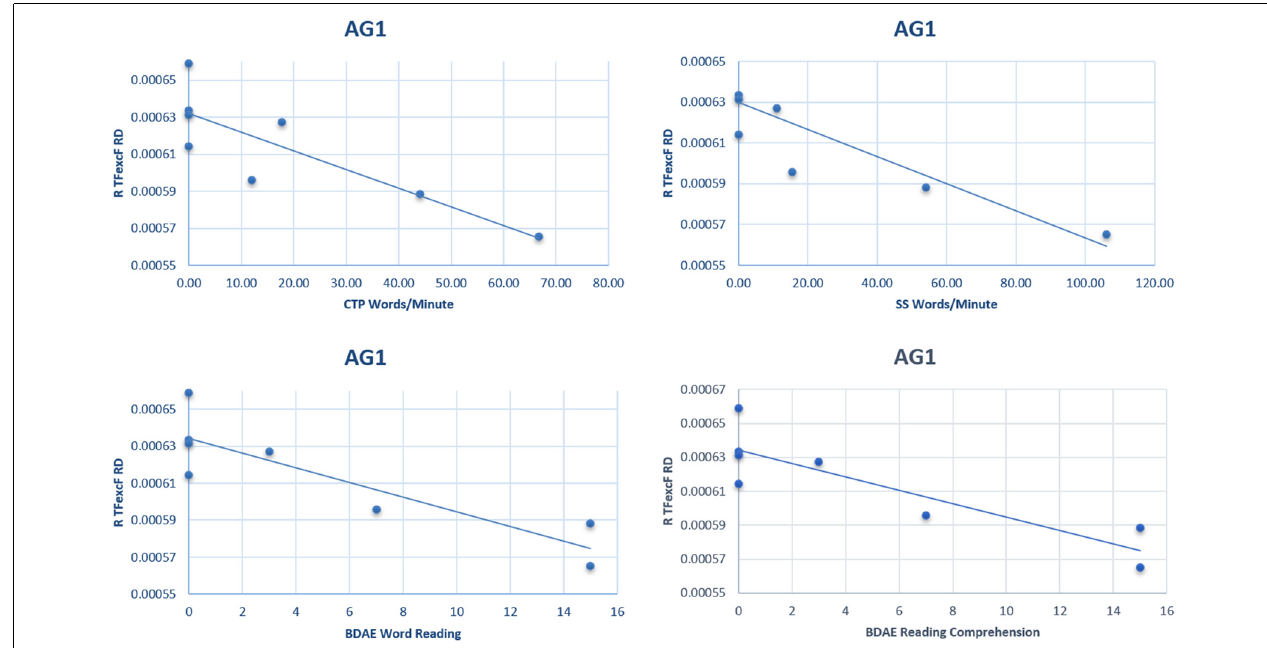
FIGURE 9 | Scatterplots of the significant correlations between language performance and radial diffusivity (RD) of the right hemisphere TFexcF in the AG1 subgroup. BDAE, Boston Diagnostic Aphasia Examination; CTP, Cookie Theft Picture test; SS, Stroke Story test.